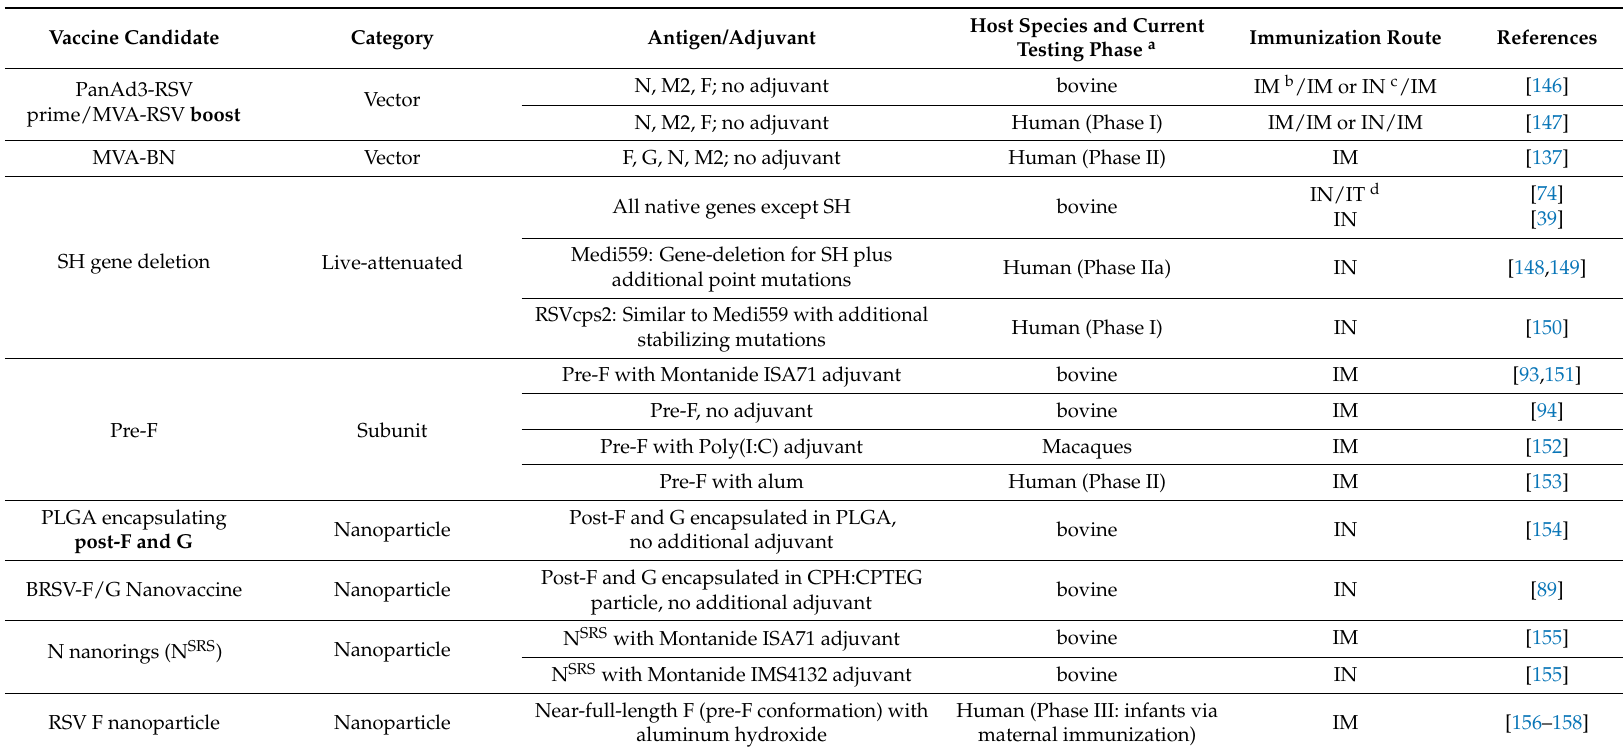
Table 2. Overview of vaccine candidates which have undergone preclinical testing in